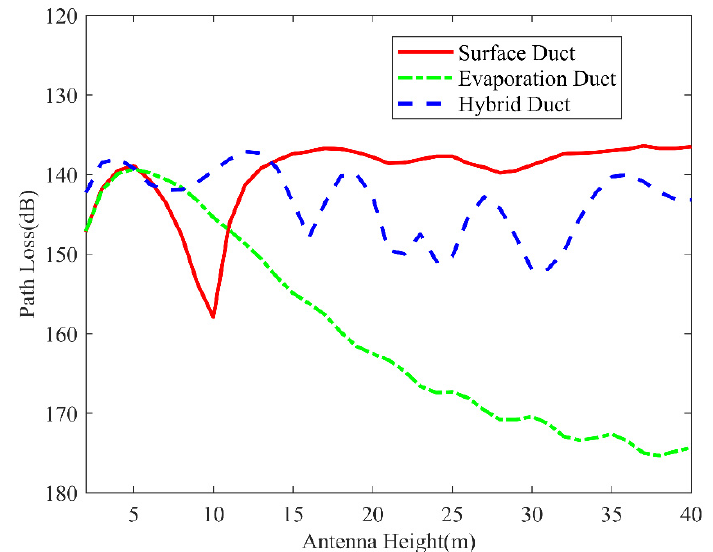
Figure 19. Path loss of microwave propagation at di ff erent antenna heights with a frequency of 8 GHz and a receiving distance of 200 km.